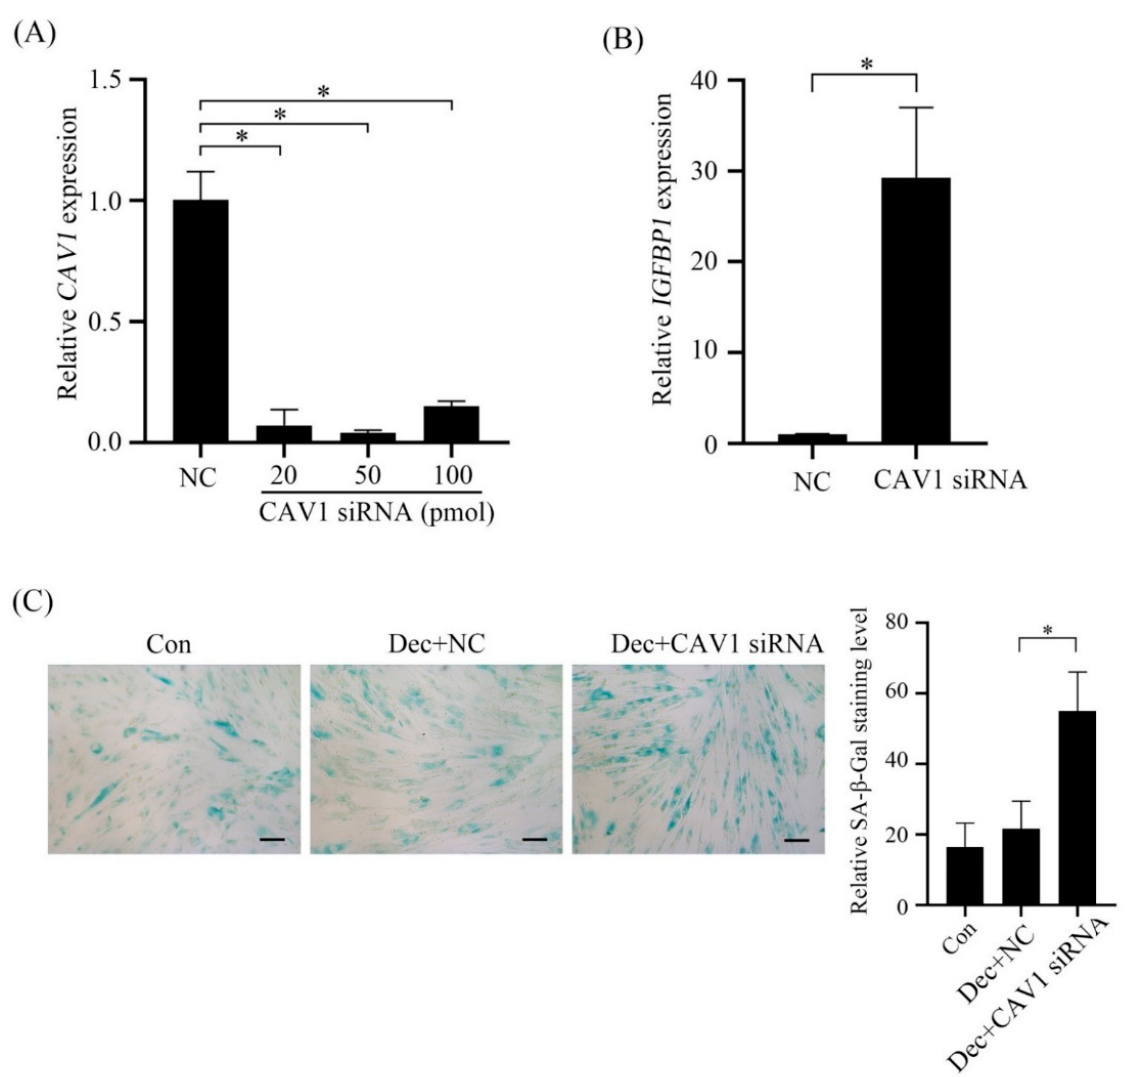
Figure 9. Effects of Caveolin-1 siRNA on human in vitro decidualization. ( A ) Real-time PCR analysis of Caveolin-1 mRNA expression after stromal cells were transfected with Caveolin-1 siRNA. ( B ) Real-time PCR analysis of IGFBP1 mRNA expression after stromal cells were transfected with Caveolin-1 siRNA. ( C ) SA- β -Gal staining in stromal cells after transfected with Caveolin-1 siRNA for 2 days. Scale bar = 20 µ m. *, p < 0.05.